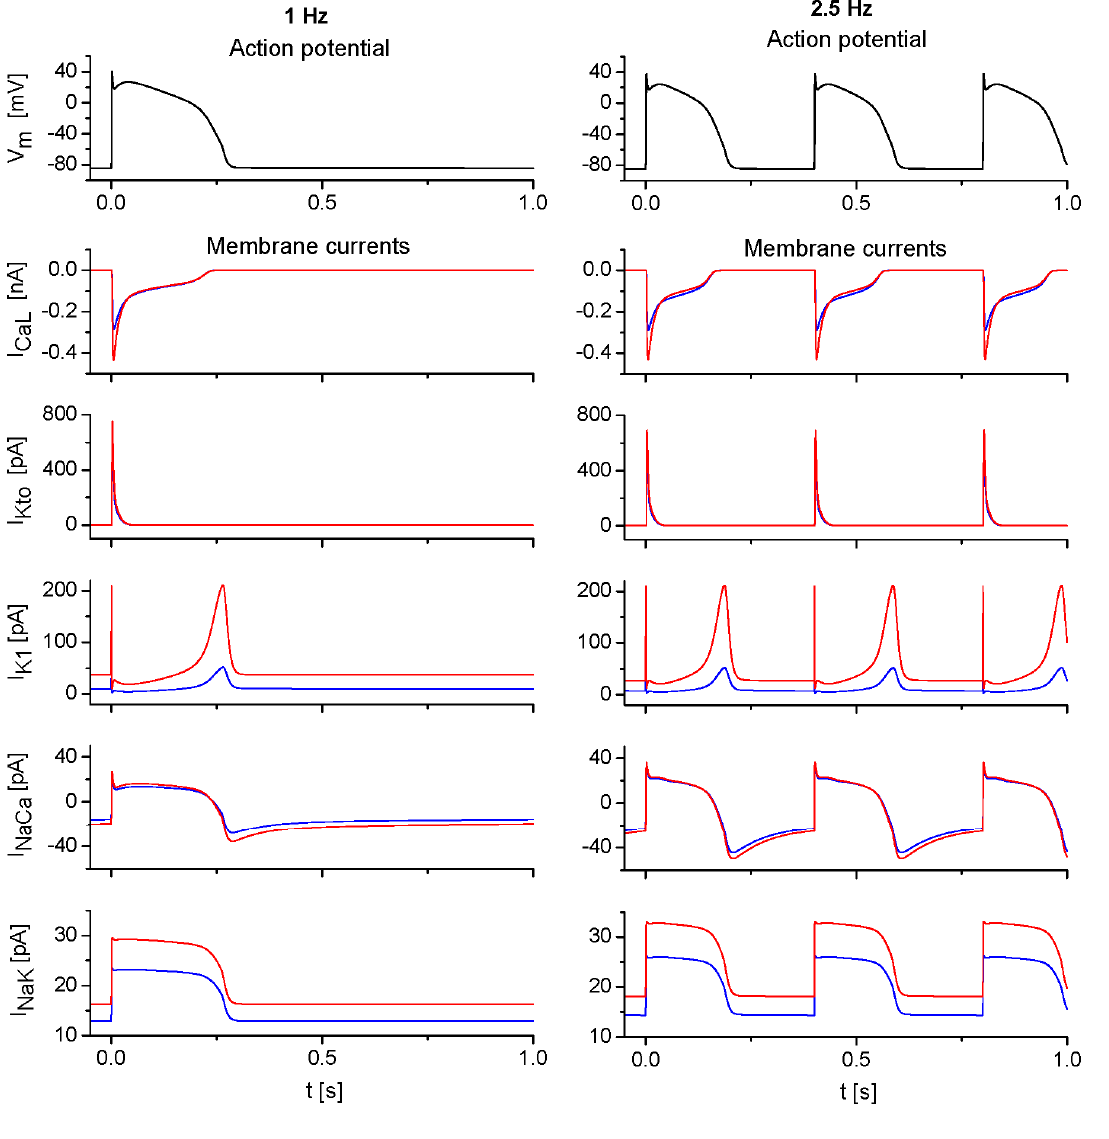
, I , I , I , I ) CaL Kto K1 NaCa NaK